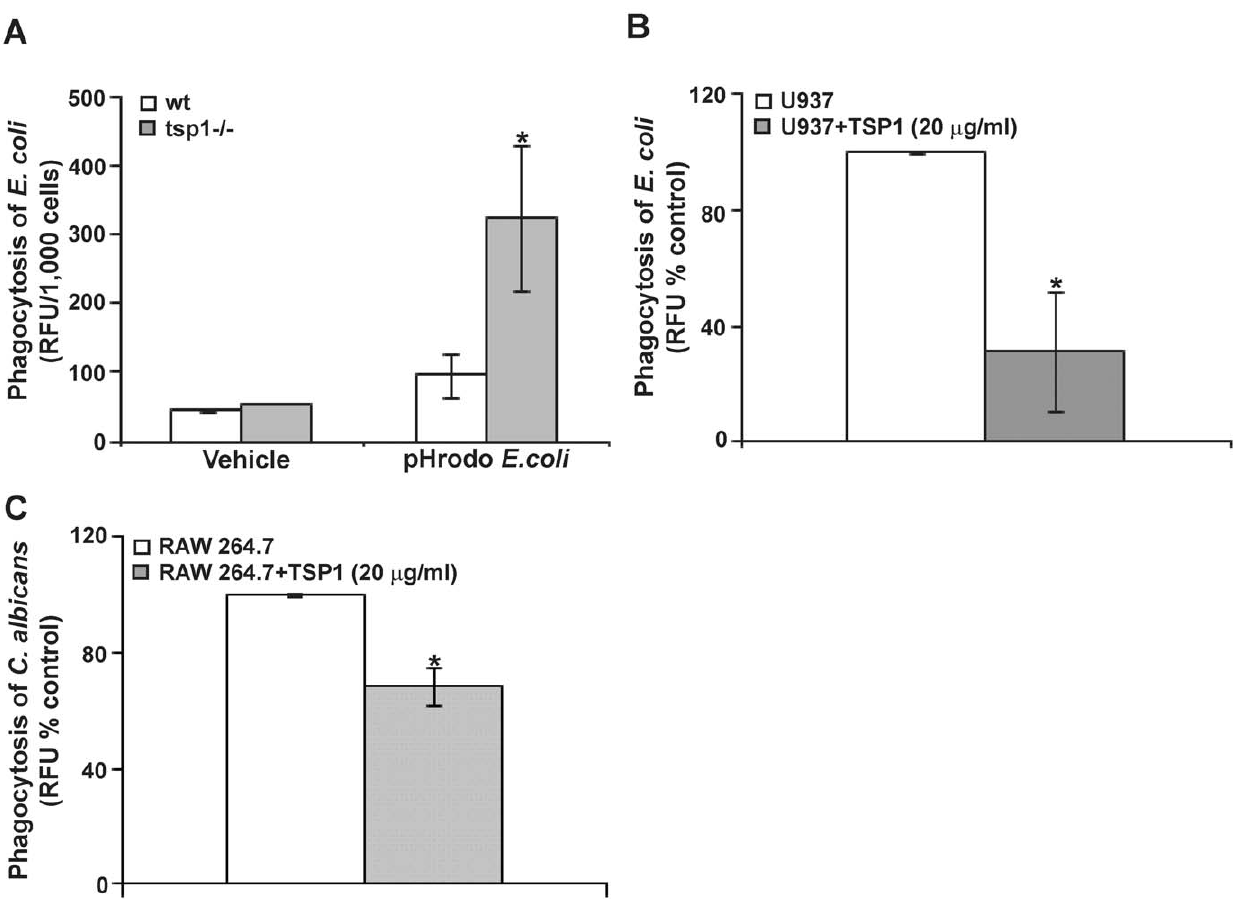
Figure 6. TSP1 inhibits phagocytosis invivo and invitro . (A) wt and tsp1 2 / 2 mice received 1 ml of 1% l -carrageenan (intra-pouch) and 23 hours later were injected with pHrodo-labeled E. coli Bioparticles H or vehicle control (HBSS/20 mM HEPES pH 7.4). After 1 h incubation, cells were harvested, counted and placed in a fluorometer. The results are presented as the ratio relative fluorescence units (RFU)/1,000 cells. Data are pooled from two independent experiments and represent the mean 6 SEM, n=6 2 8 mice/group. (B) 1 6 10 5 IFN- c -differentiated U937 cells/condition were incubated with FITC-labeled E. coli in the absence or the presence of soluble TSP1 for 2 h. The fluorescence intensity (mean 6 SD) is presented as a % of control RFU and is representative of four independent experiments. (C) 2 6 10 5 RAW 264.7 cells/condition were incubated with FITC-labeled C. albicans (2 yeast: 1 macrophage) in the absence or the presence of soluble TSP1 for 45 min. The results are presented as a % of control RFU. Data are pooled from three independent experiments (mean 6 SEM). *indicates p ,